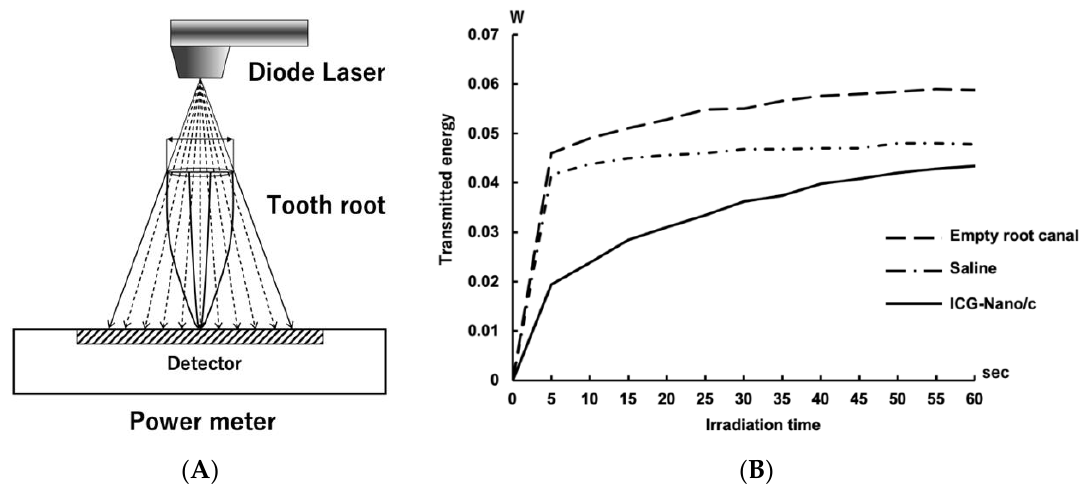
Figure 6. Transition of the light energy transmitted through the tooth root. ( A ) Schematic diagram of laser irradiation and detection. The guided circle of the irradiation range was matched to the outer circumference of the root. ( B ) The transition of the energy transmitted through the root is shown in a polygonal line graph. The value displayed in the power meter was recorded every 5 s ( n =